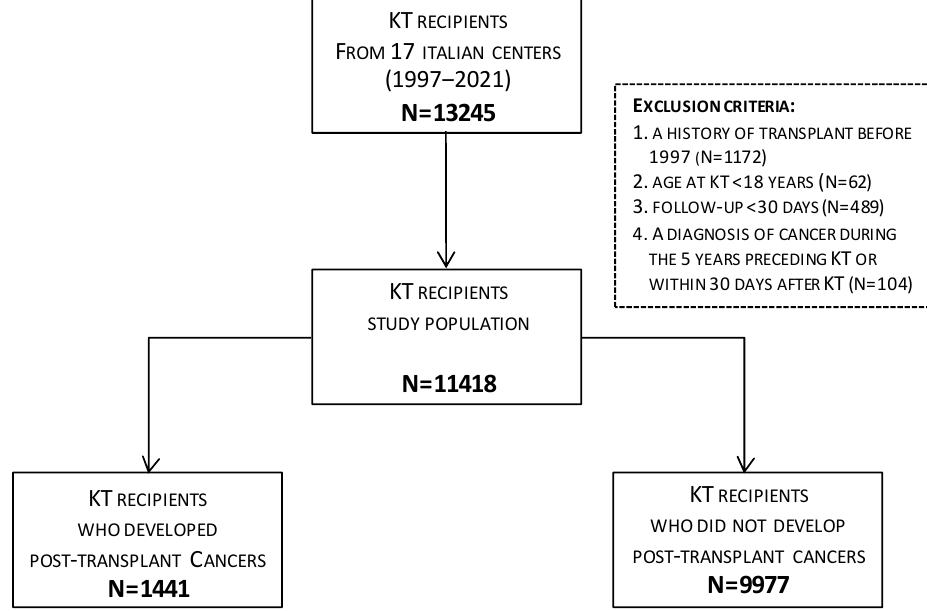
Figure 1. Flow chart of kidney transplant (KT) recipients selection.